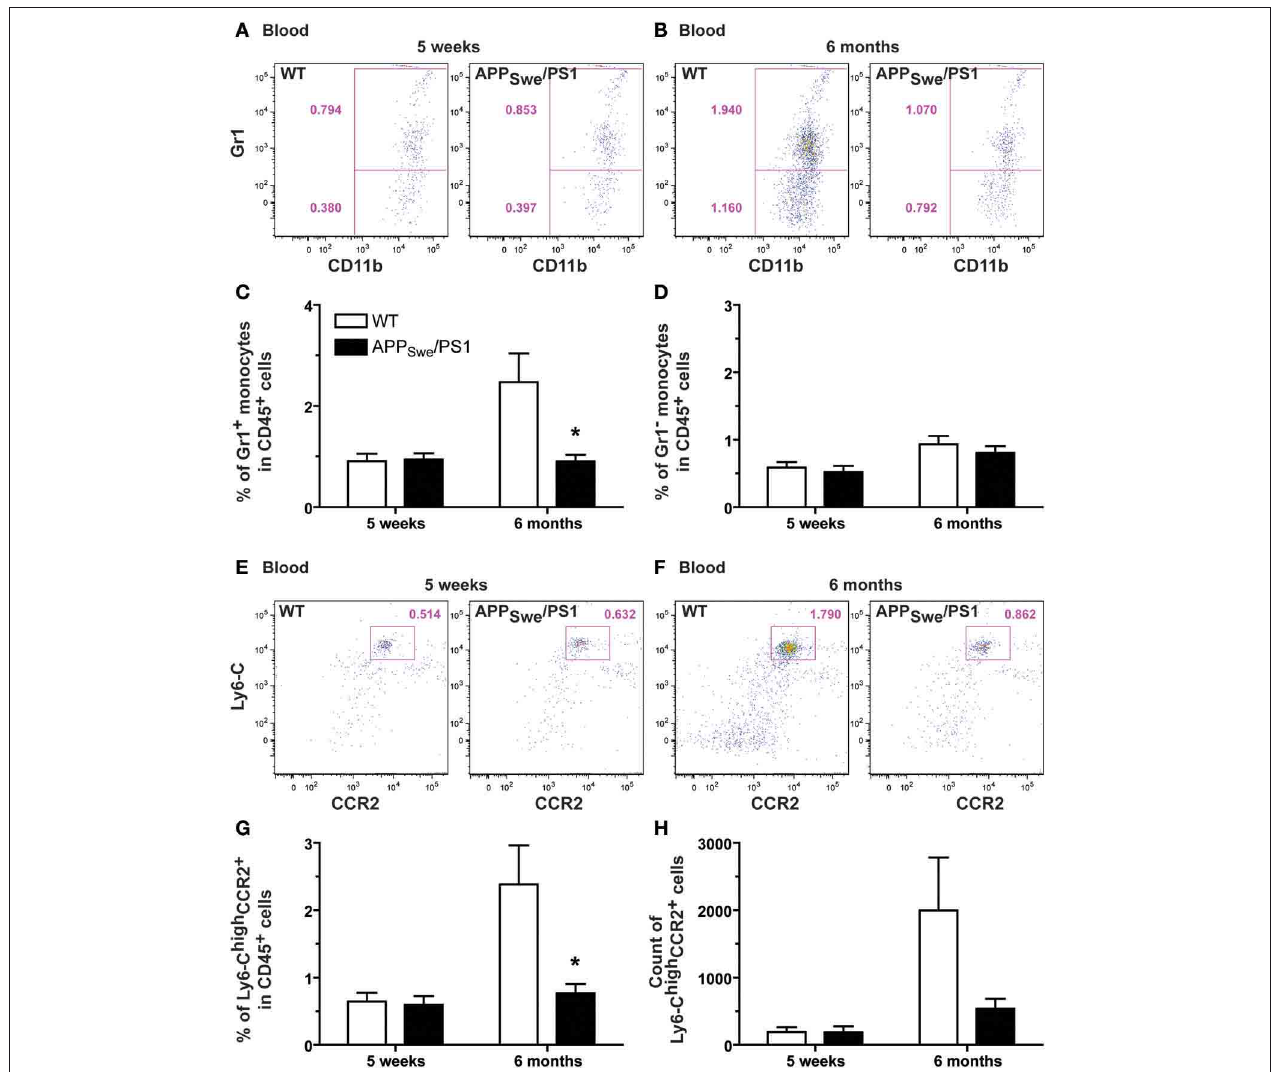
bloodstream of 6-month-old WT mice, but this phenomenon was totally prevented in APP Swe /PS1 mice (B and C) . Although these mice failed to exhibit such increase in Gr1 + monocytes, they had similar number of blood Gr1 − monocytes when compared to WT animals (B and D) . The low frequency of Gr1 + Ly6-C high CCR2 + monocytes was confirmed in 6-month-old APP Swe /PS1 mice using more specific markers of the Gr1 + monocyte (e.g., Ly6-C and CCR2) (E–H) . Results are expressed as the Mean ± SEM; n =